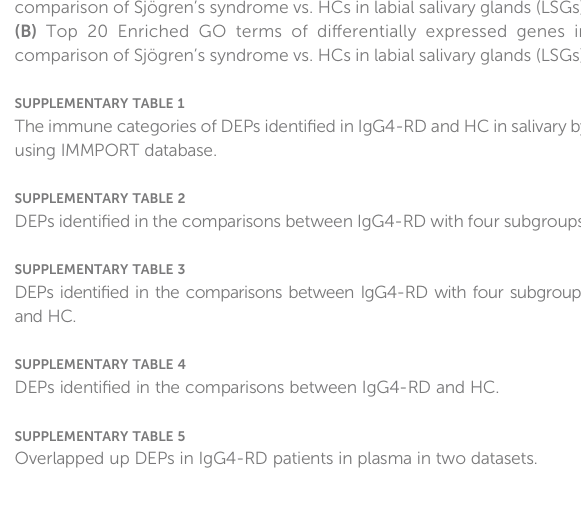
SUPPLEMENTARY FIGURE 1 (A) Enriched GO and KEGG terms of DEPs in comparison of Mikulicz group vs. HC in plasma. (B) Enriched GO and KEGG terms of DEPs in comparison of Hepatobiliary group vs. HC in plasma. (C) Enriched GO and KEGG terms of DEPs in comparison of Head and neck group vs. HC in plasma. (D) Enriched GO and KEGG terms of DEPs in comparison of Retroperitoneal aorta group vs. HC in plasma. SUPPLEMENTARY FIGURE 2 Immune categories of DEPs identi fi ed in saliva between each IgG4-RD subgroup and HC samples. Different color represents various immune related categories from IMMPORT database. (A) Mikulicz group; (B) Hepatobiliary group; (C) Head and neck group; and (D) Retroperitoneal aorta group. SUPPLEMENTARY FIGURE 3 Protein interactive network of LGALS3. SUPPLEMENTARY FIGURE 4 (A) Enriched GO and KEGG terms of differentially expressed genes in comparison of Sjögren ’ s syndrome vs. HCs in labial salivary glands (LSGs). (B) Top 20 Enriched GO terms of differentially expressed genes in comparison of Sjögren ’ s syndrome vs. HCs in labial salivary glands (LSGs). SUPPLEMENTARY TABLE 1 The immune categories of DEPs identi fi ed in IgG4-RD and HC in salivaryby using IMMPORT database.